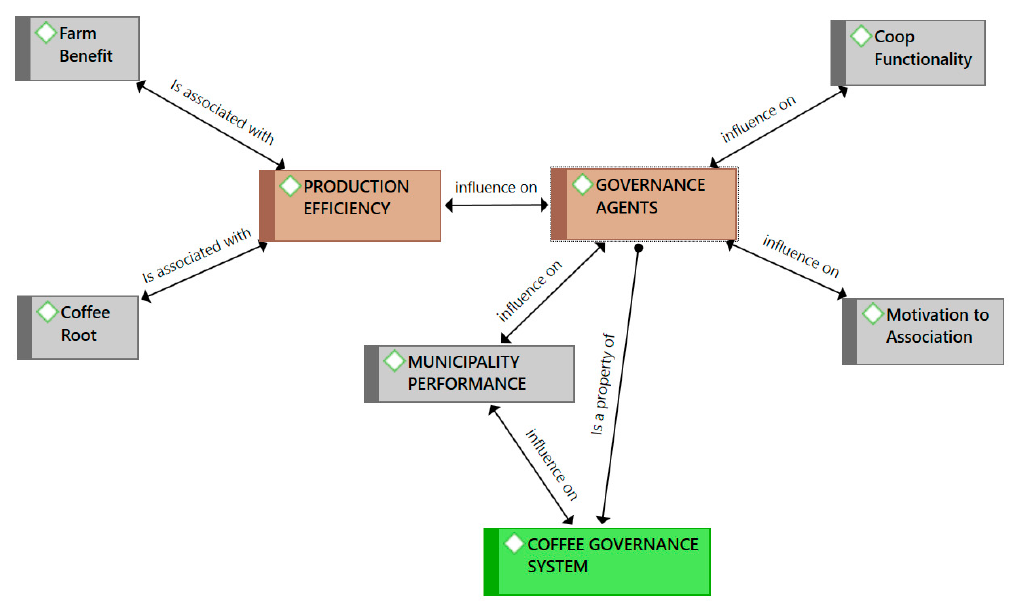
Figure 5. Tangible and intangible components of the TG associated with coffee. The author.